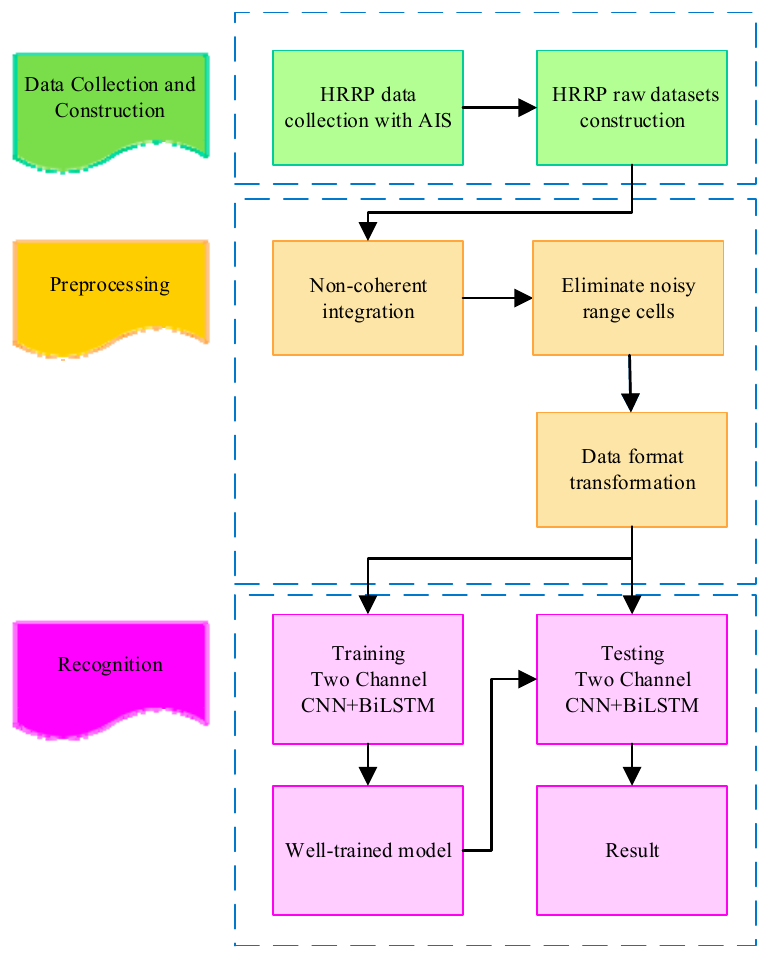
Figure 1. Block diagram of the proposed approach.